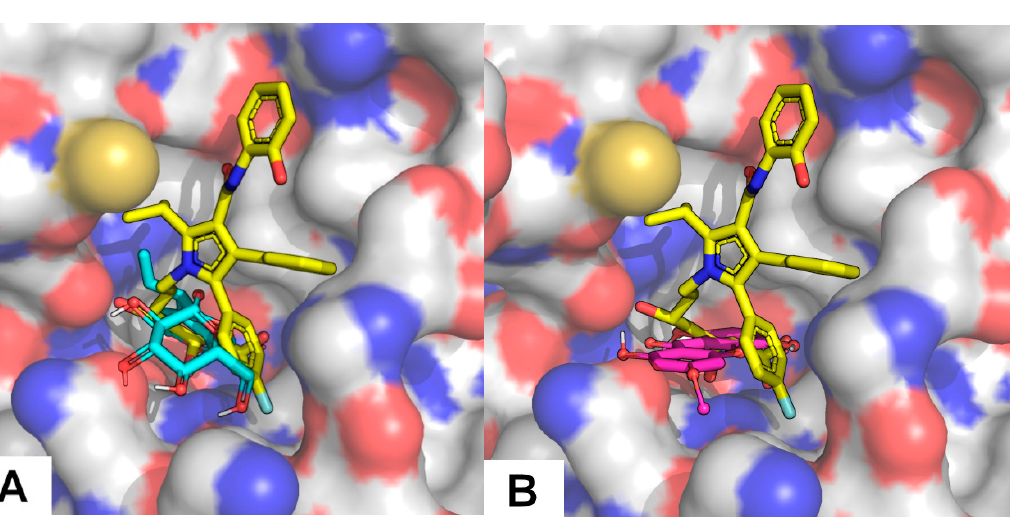
Figure 5. The lowest energy solutions from the docking calculations of a gentiopicroside (cyan— A ) and xanthone 03 (pink— B ) overlapped with the crystallographic structure of an atorvastatin derivative (yellow—1HW9); [53] in human HMGR (white carbons surface).